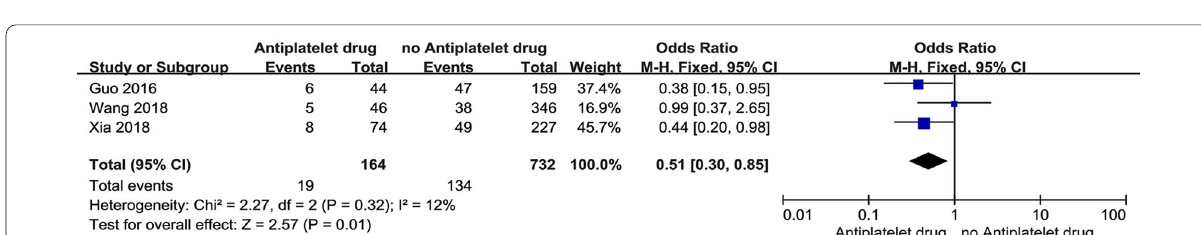
Fig. 12 Forest plot showing the relationship between anti-platelet drug and preoperative DVT in 2 groups. CI interval, df degrees of freedom, M-H